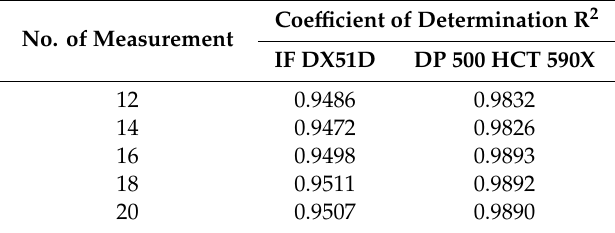
Table 6. Coe ffi cient of determination (R 2 ) for calculated